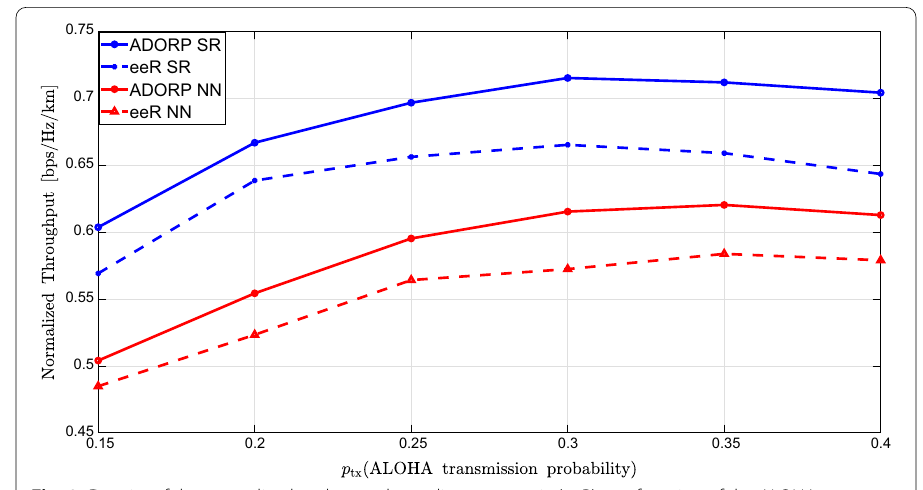
Fig. 8 Density of the normalized end-to-end rate distance metric (eeR) as a function of the ALOHA transmission probability in a full network simulation where each node was equipped with N = 2 . The figure depicts the performance of the SR and the NN routing schemes, for a path loss exponent of α =